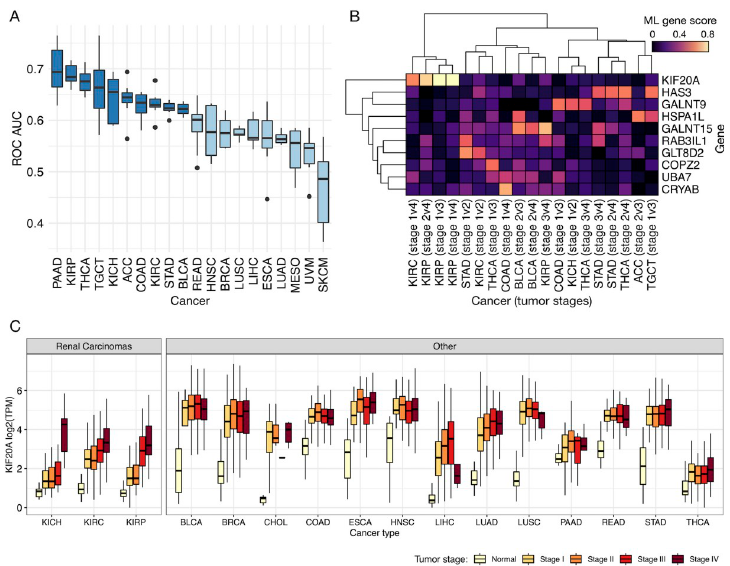
Fig 5. PSP genes associated with tumor stage. ( A ) Boxplots of mean ROC AUC values for the prediction of tumor stage based on PSP gene expression. Dark blue boxes indicate the cancer types with the top 10 ROC AUC values on average, which were used in subsequent analyses. ( B ) Heatmap of consensus ML gene scores for the different stage comparisons of each cancer type, showing only the top 10 scoring genes on average, and only cancer-stage pairs with at least one gene score � 0.5. ( C ) Expression (log-transformed TPM) of KIF20A among different cancer types, grouped by tumor